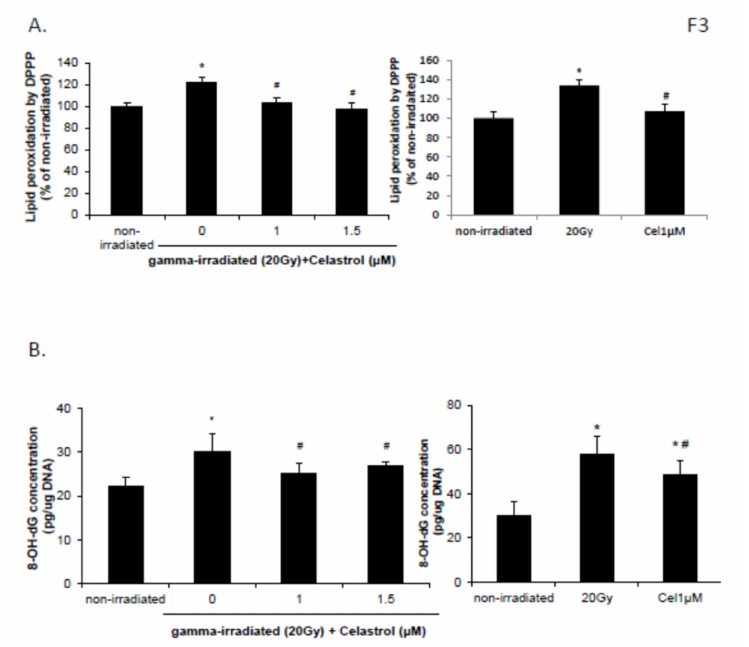
Figure 3. E ff ects of celastrol on lipid peroxidation ( A ) and oxidative DNA damage ( B ) in HaCaT cells (left panel) and skin fibroblast cells (right panel) after gamma irradiation. Cells were subjected to gamma irradiation with 20 Gy followed by 24 h treatment with celastrol at designated concentrations. DMEM or EMEM group without any drug treatment and gamma radiation exposure served as control. ( A ) Lipid peroxidation was assayed by DPPP. ( B ) Oxidative DNA damage was evaluated by 8-OH-dG EIA kit. All data are expressed as mean ± S.E.M ( n = 5). Comparisons between groups were analyzed by One-Way ANOVA followed by Tukey’s post-hoc test. * p < 0.05 vs. non-irradiated. # p < 0.05 vs. irradiated and no drug